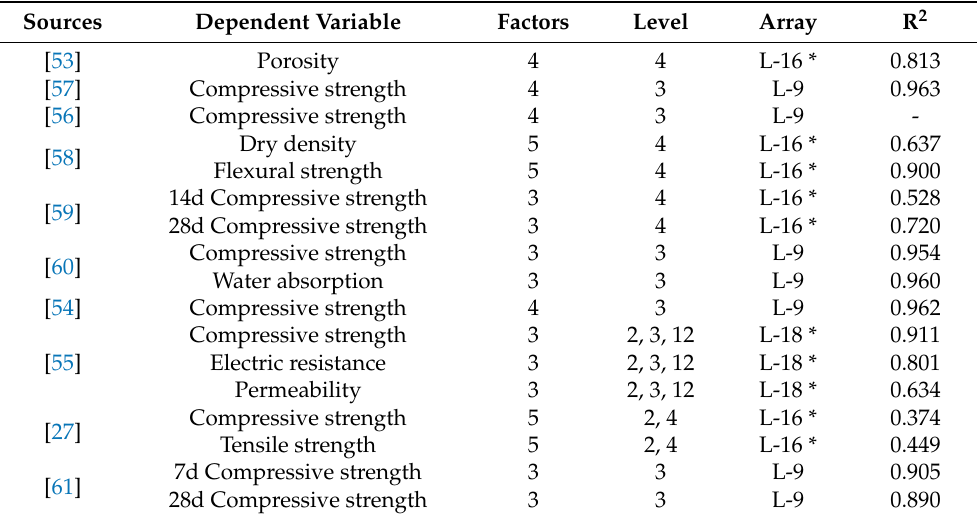
Table 5. Taguchi method and regression